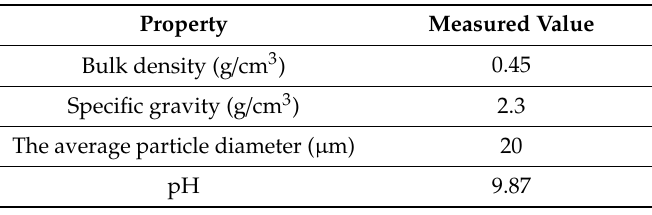
Figure 3. Particle size distribution of the diatomite.